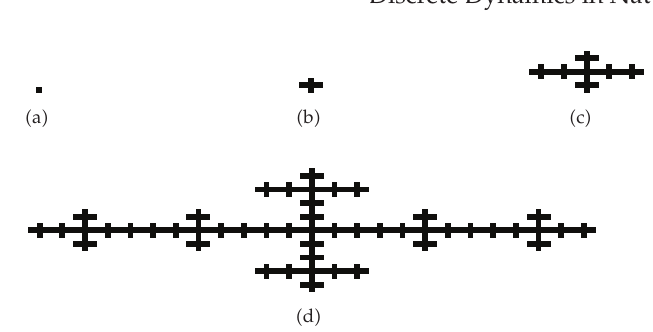
Figure 3: A sketch map of the self-a ffi ne growing fractal (cid:3) the first four steps are obtained by Vicsek (cid:5) 31 (cid:6)(cid:4)